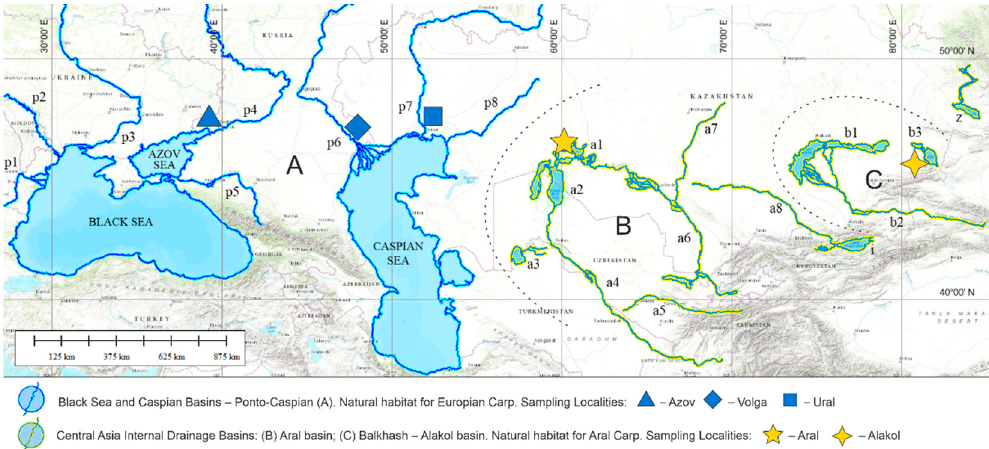
Figure 1. Natural distribution of wild common carp in Ponto-Caspian and Central Asia regions. Sampling localities ac- cording to the color legend and natural water reservoirs for European and Aral carp. Ponto-Caspian region: p1—Danube